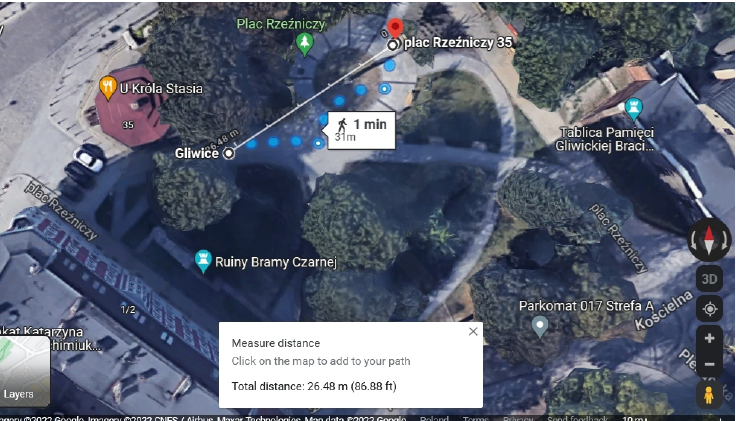
Figure 3. The distance between the senior’s location and the waypoint for the Skwer Rzezniczy waypoint on the Gliwice Downtown Path (source: Google Maps/Google Earth,